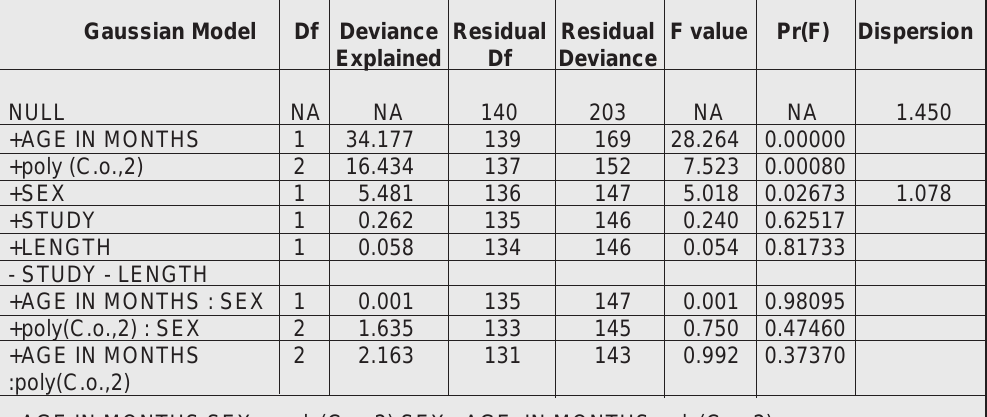
Table 5. Analysis of deviance of log Pseudoterranova decipiens abundance in pups. Terms in ita- lics not retained in final model. The preceder “poly” defines the term as a polynomial (term,de- grees of freedom). The C.o. term denotes log Contracaecum osculatum abundance.